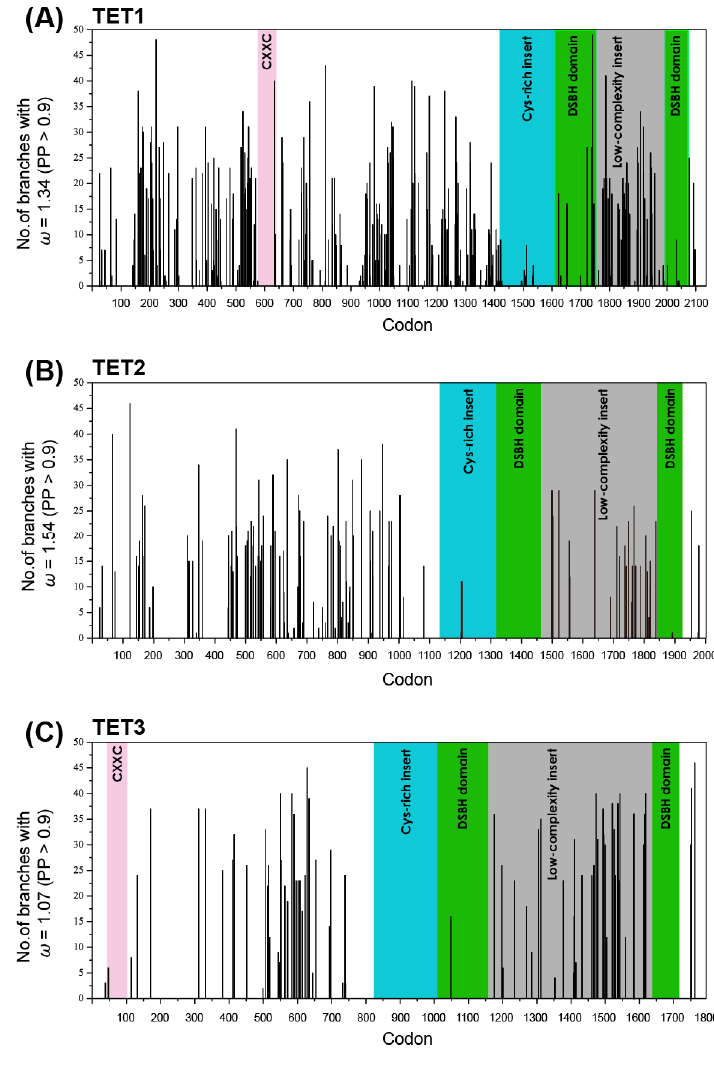
Figure 2. Distribution of branches with the ω 3 rate ratio class on each site across the TET1 ( A ); TET2 ( B ) and TET3 ( C ) alignments. The CXXC, Cys-rich insert, DSBH and low-complexity insert domains are in color. The x -axis represents the position of codons in the alignment, and the y -axis represents the number of branches exhibiting the ω 3 rate ratio class (PP > 0.9).